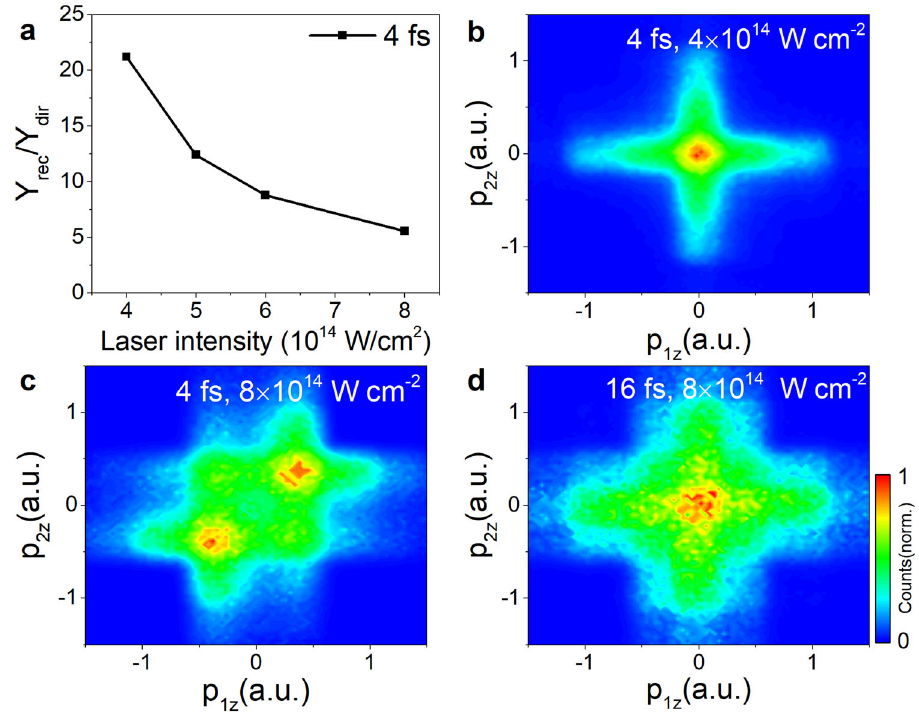
Fig. 6 Simulated results for below-threshold nonsequential double ionization of Ar + which fi nally becomes Ar 3 + in 400 nm laser pulse. a Ratio between the integrated yields of recolliding and direct trajectories for e 2 . b – d Normalized correlated electron momentum distributions. The carrier- envelope phases are